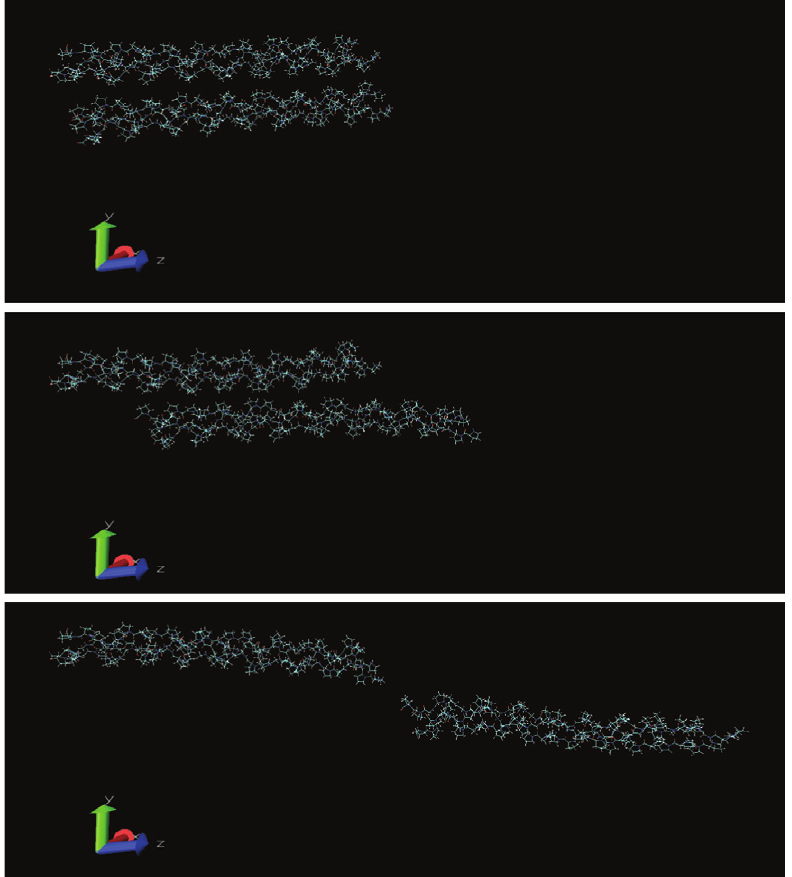
Figure 9 Snapshots of collagen molecular separation in numerical shear